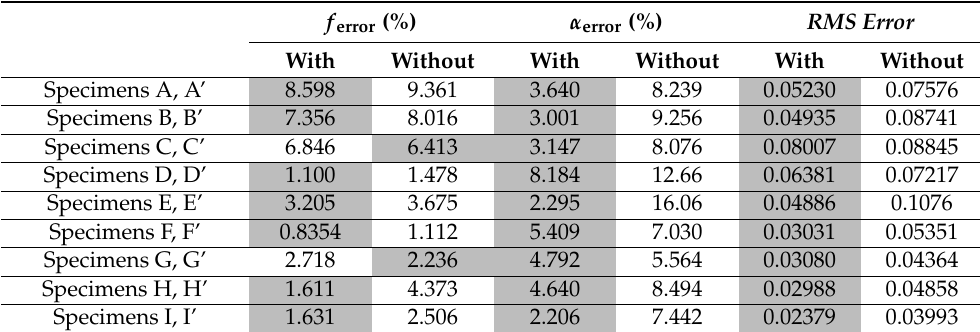
Table 8. Mean absolute values of the error indices (Equations (4)–(6)) for the four air-back cavity depth conditions for specimens A–I and A’–I’. ‘With’ means ‘with holes in the background parts’, and ‘Without’ means ‘without holes in the background parts’. To compare the ‘With’ and ‘Without’ conditions, the smaller values are hatched. f error (%) α error (%) RMS Error With Without With Without With Without Specimens A, A’ 8.598 9.361 3.640 8.239 0.05230 0.07576 Specimens B, B’ 7.356 8.016 3.001